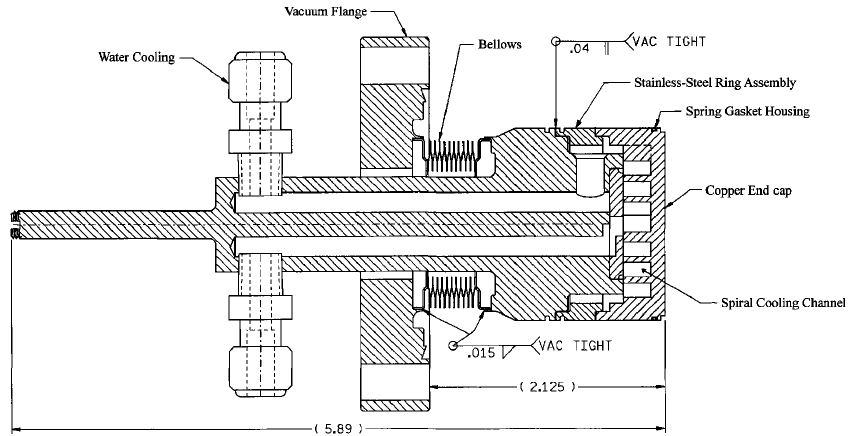
FIG. 6. Assembly schematic of end cap and piston. All dimensions are in